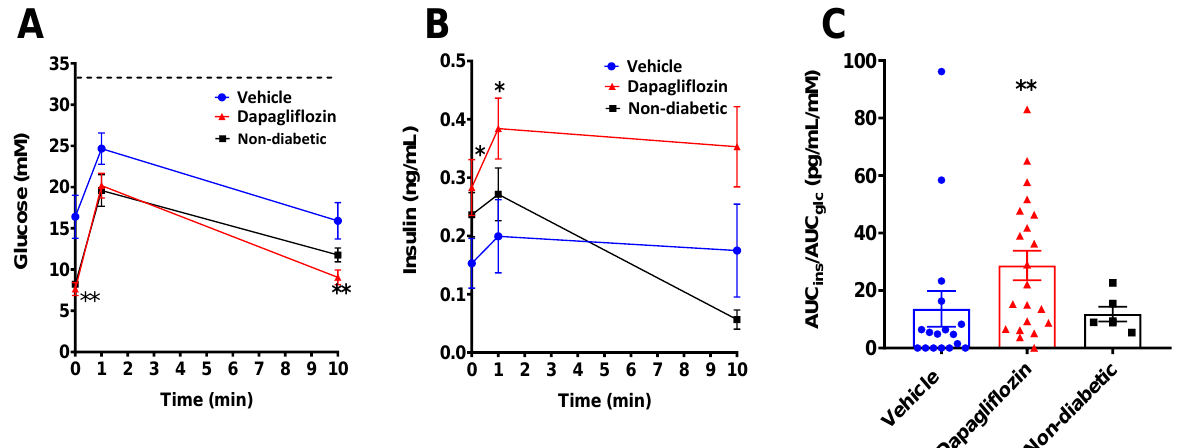
Figure 2. Dapagliflozin improved the human islet response to glucose and arginine. Intravenous